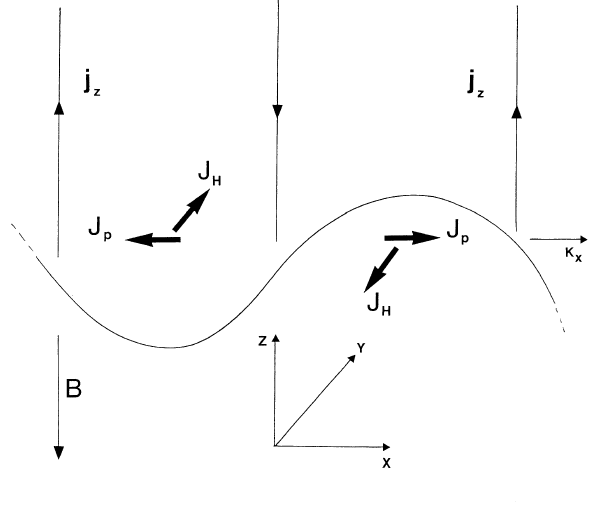
Fig. 1. Simplified picture of the current system, excited by a periodic acoustic motion, and constituted with field-aligned ( j z ), Pedersen ( J P ) and Hall ( J H